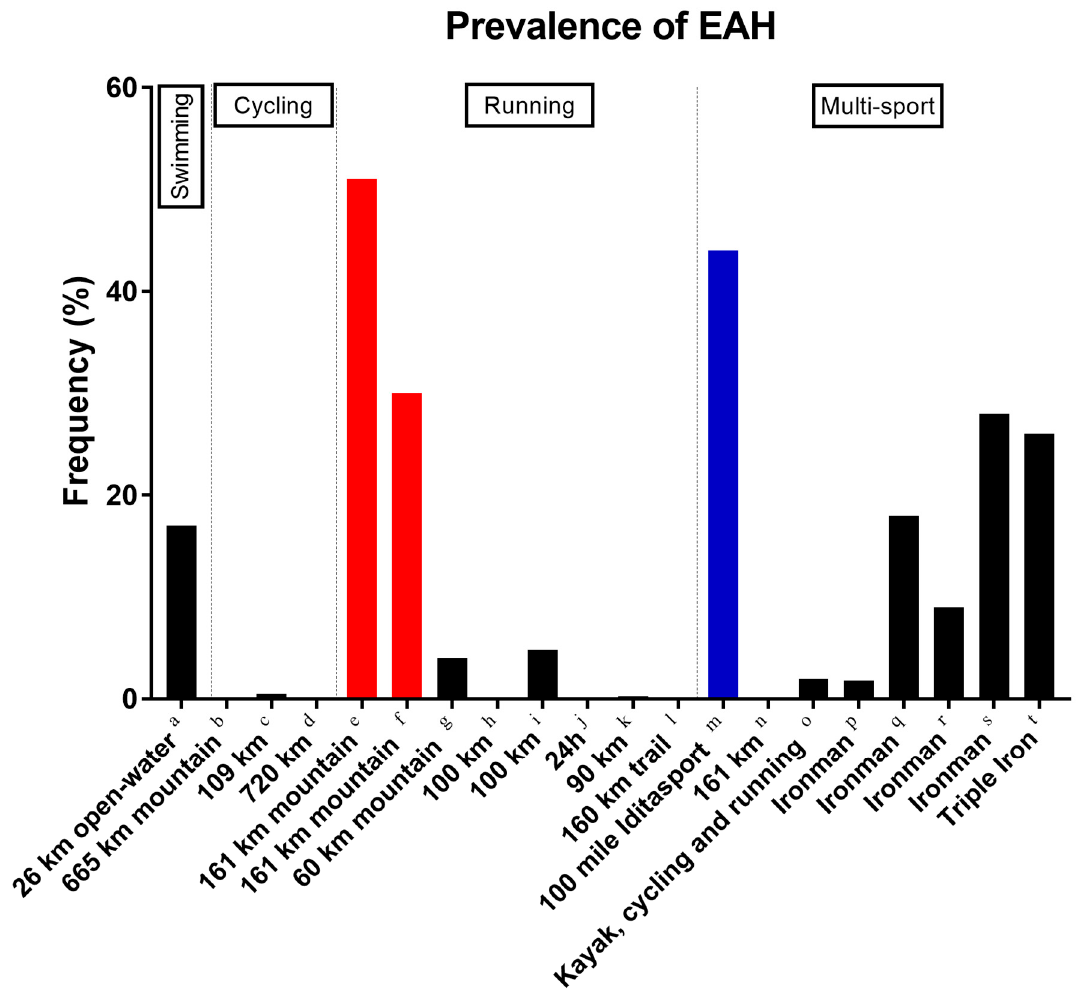
Figure 4. Prevalence of exercise-associated hyponatremia (EAH) in ultra-endurance athletes competing in swimming, cycling, running, and multi-sports disciplines. Red and blue highlight hot and cold environment. a = [77], b = [89], c = [90], d = [87], e = [64], f = [86], g = [83], h = [91], i = [82], j = [92], k = [73], l = [63], m = [79], n = [93], o = [94], p = [95], q = [88], r = [96], s = [97], t = [98].